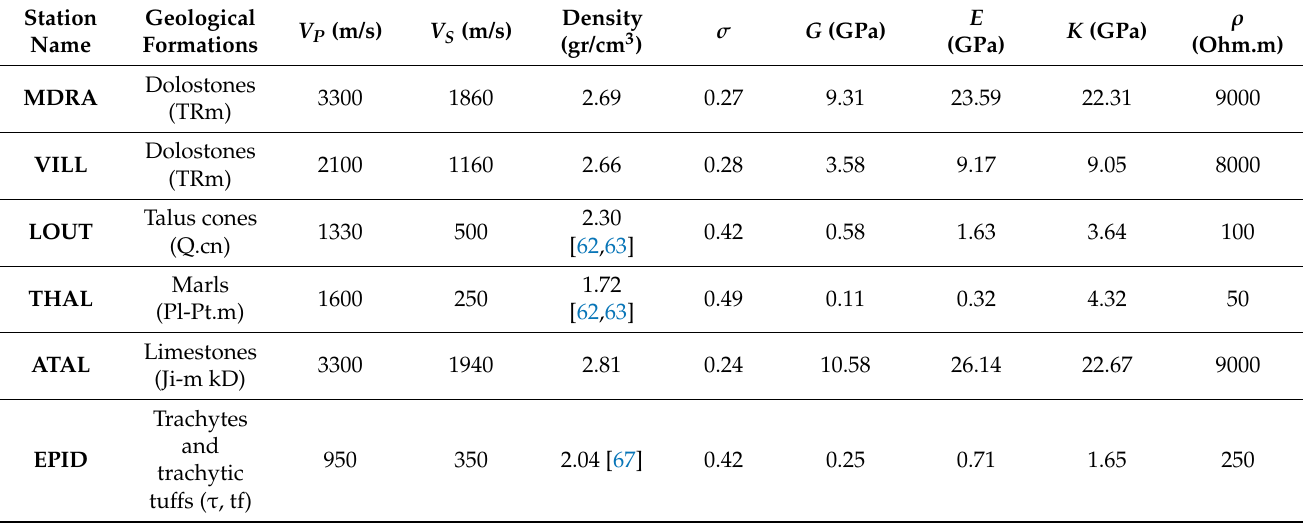
Table 4. Seismic velocities and calculated elastic moduli of the geological formations.